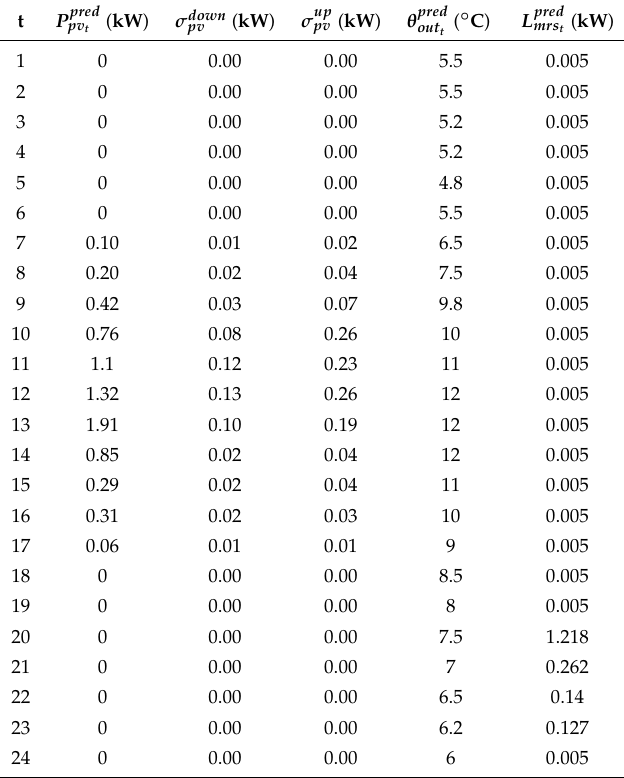
Table 1. Predicted data of uncertain variables